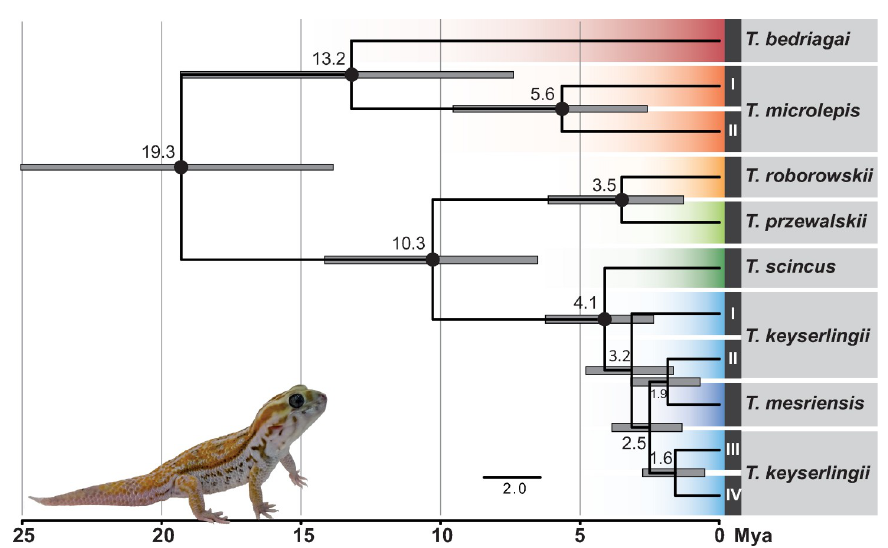
Fig 4. Time-calibrated species tree of Teratoscincus . Mean age estimates are provided above the nodes with horizontal bars representing the 95% highest posterior densities. Black circles represent nodes with posterior probability values � 0.95. Specimen depicted is T . keyserlingii from the UAE. Photo credit: Salvador Carranza.